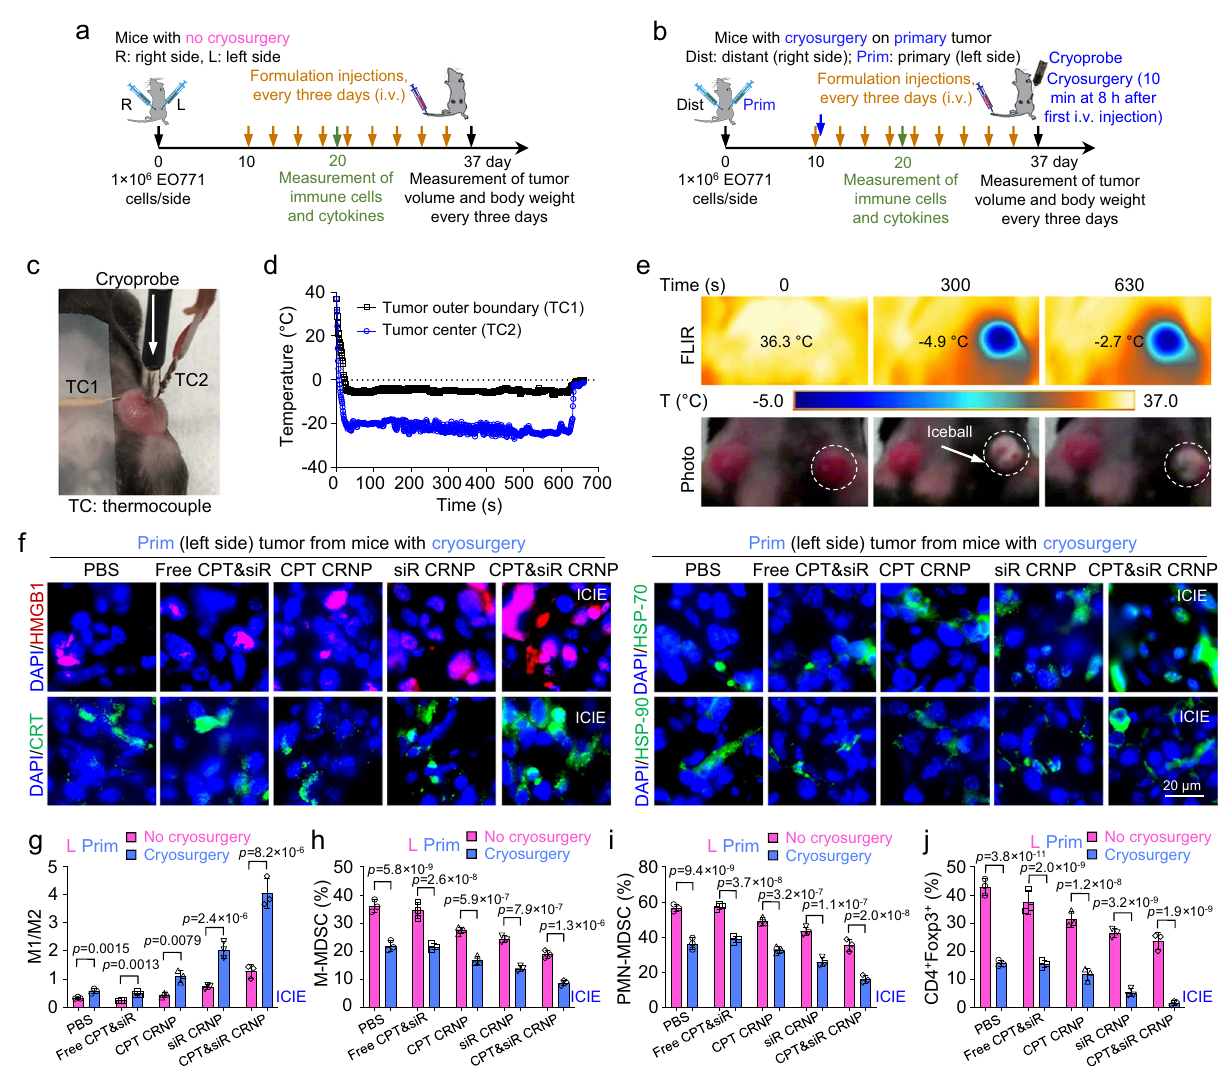
Fig. 5 | ICIE turns immunologically “ cold ” TME into a “ hot ” one. a A schematic illustrationoftheexperimentaldesignformicereceivingonlyintravenousinjection of various formulations every 3 days with no cryosurgery. For these mice, the tumorsontheleftandrightsidesareindicatedasLandRtumors,respectively. b A schematic illustration of the in vivo experimental design for mice receiving both intravenous injection of various formulations and cryosurgery done only on the primary(Prim)tumorsontheleftside.Thetumorsthatundergonofreezingonthe right side of these mice are indicated as distant (Dist) tumors. Cryosurgery was performedat8hafterthe fi rstinjectionoftheformulations. c Atypicalphotograph of the tumor area of a mouse during cryosurgery. Thermocouple 1 (TC1) and TC2 are for monitoring the temperature in tumor outer boundary and center (next to the cryoprobe), respectively. d Typical thermal histories recorded at the tumor boundary and center during the cryosurgical procedure. e Representative FLIR infrared images and photographs of mice showing the tumor temperature and appearance at three different time points before (0s), during (300s), and after